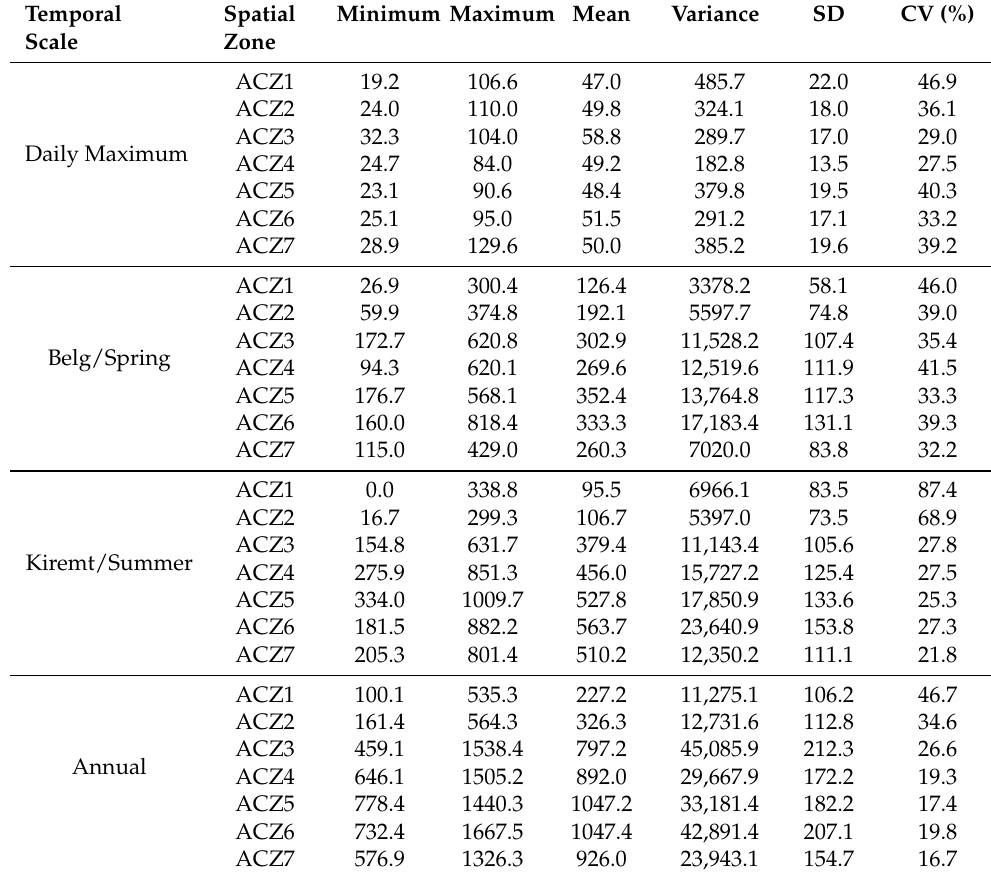
Table 3. Statistical summary of daily maximum, rainy seasons, and annual rainfall